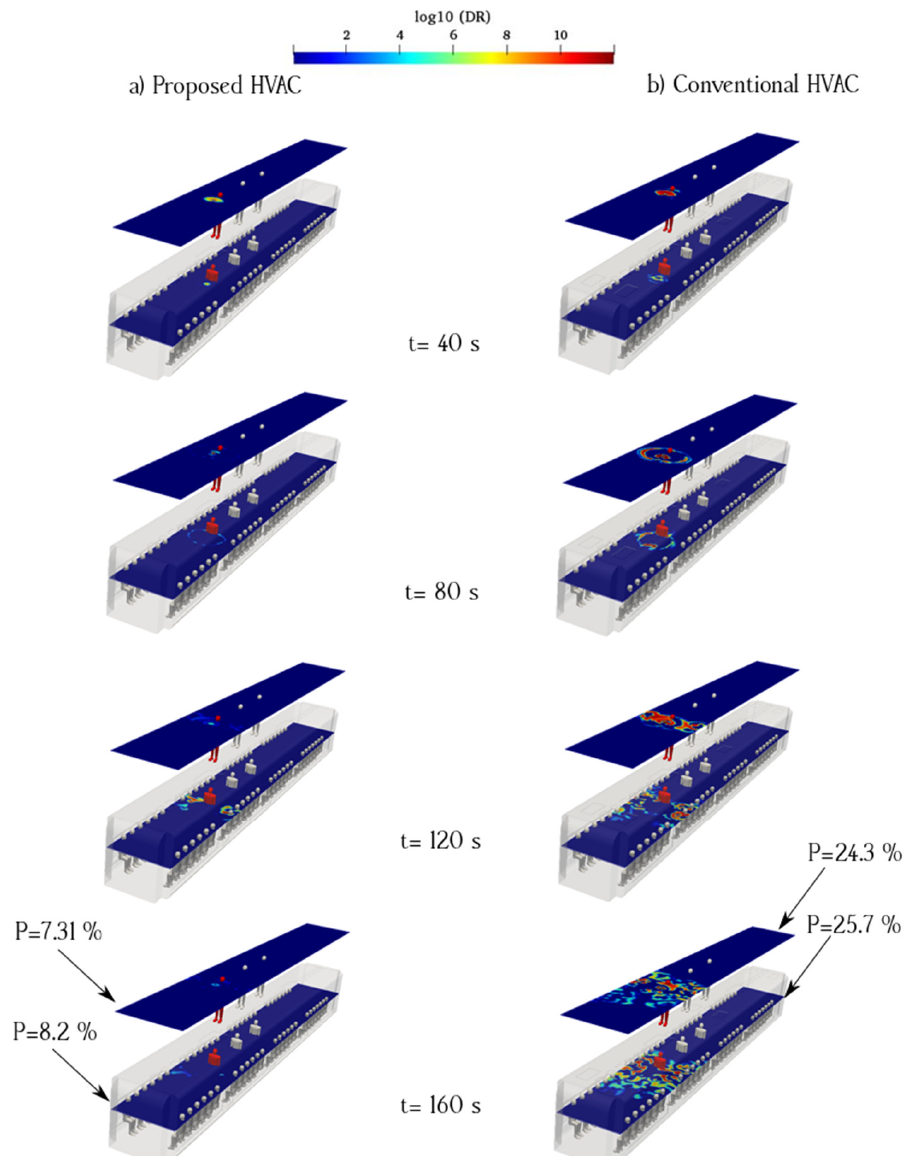
Figure 13. Time evolution of the counters of log 10 (DR) when the infected individual is standing near the recirculated ducts of the proposed ( a ) and conventional ( b ) HVAC systems (Case 5).